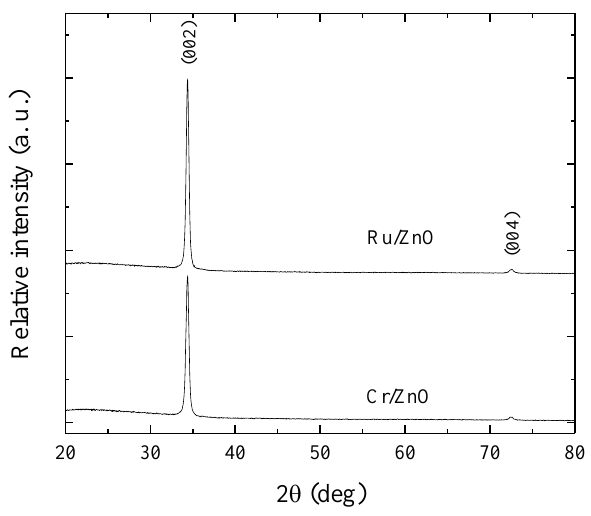
Figure 2. X-ray diffraction patterns of ZnO:Cr and ZnO:Ru thin